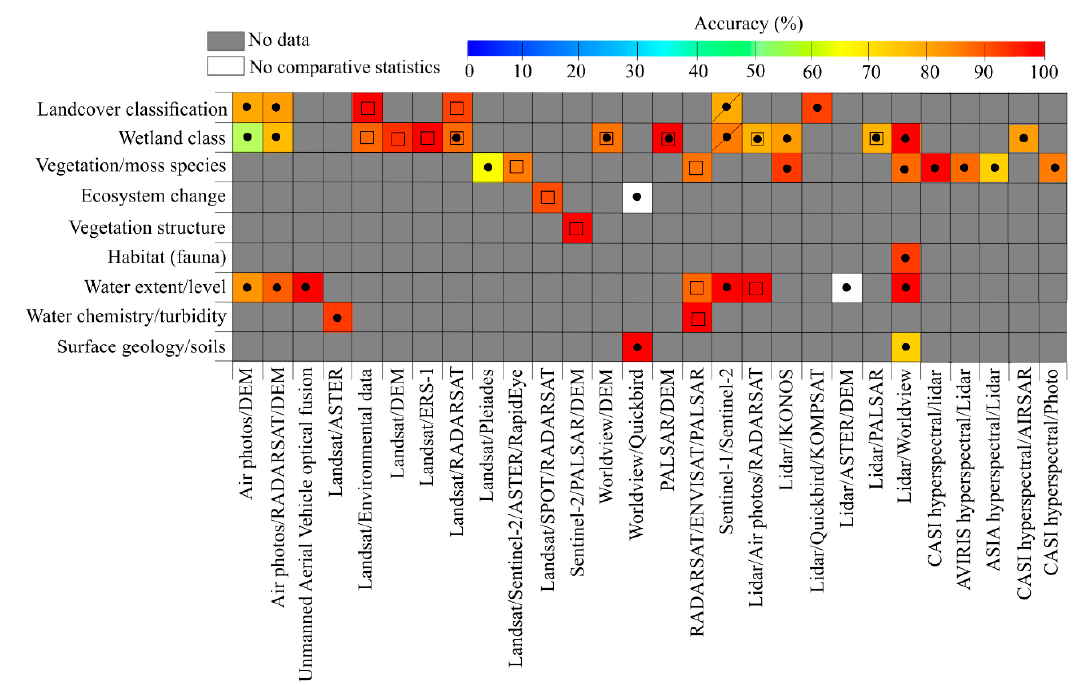
Figure 6. Accuracy using multiple remote sensing platform data conflation methods. Symbols represent local ( ● ) (up to 100 km 2 with a focus on individual wetlands), regional ( □ ) (up to 25,000 km 2 or covering a region such as a province) and national (/) scales. Multiple symbols indicate that two articles used the same sensors (only a maximum of two articles were found to use the same configuration of sensors in the literature).